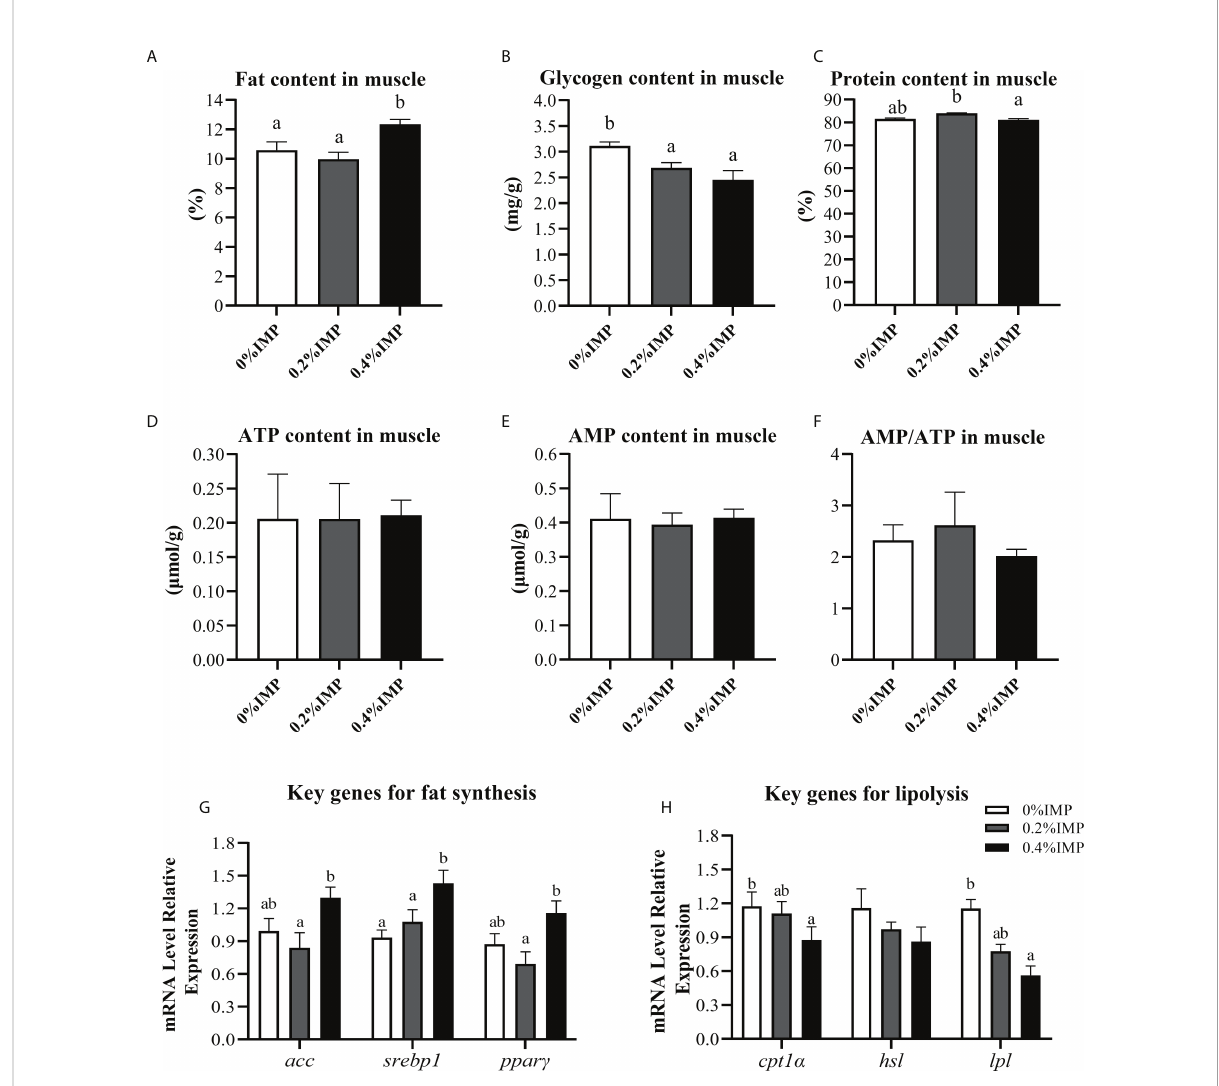
FIGURE 4 Effect of IMP supplementation on muscle energy substances and lipid metabolism. (A) The fat content in muscle was measured by the method of methanol chloroform. (B) The glycogen content in muscle. (C) The crude protein content in muscle (dry matter). (D) Adenosine 5 ′ - triphosphate (ATP) content in the muscle of groups. (E) Adenosine 5 ′ -monophosphate (AMP) content in the muscle of groups. (F) Ration of AMP and ATP in the liver of groups. (G) The expression of fat synthesis genes in muscle ( acc, srebp1 and ppar g ). (H) The expression of lipolysis genes in muscle ( cpt1 a , hsl, lpl ). Columns represent the mean ± SEM (n=6). For each index, bars without sharing a common letter indicate signi fi cant differences ( P <